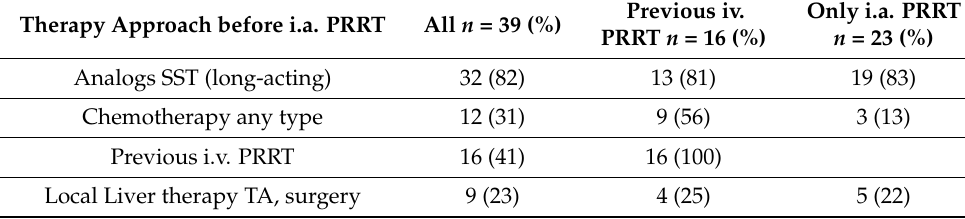
Table 2. Previous systemic therapies, considering all patients and those with previous i.v. and only i.a.